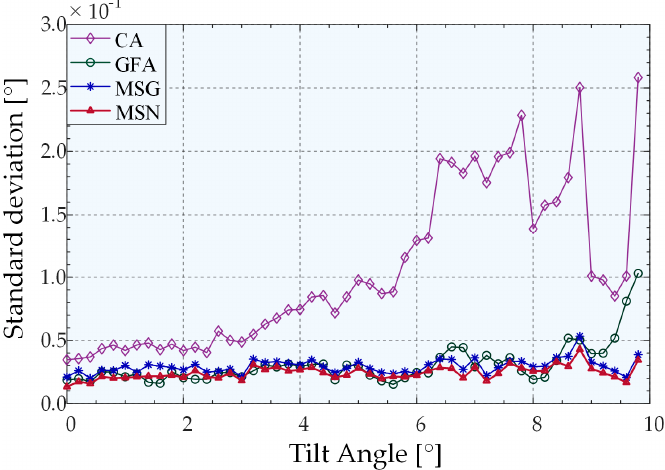
Figure 14. Angular prediction standard deviations of different algorithms.